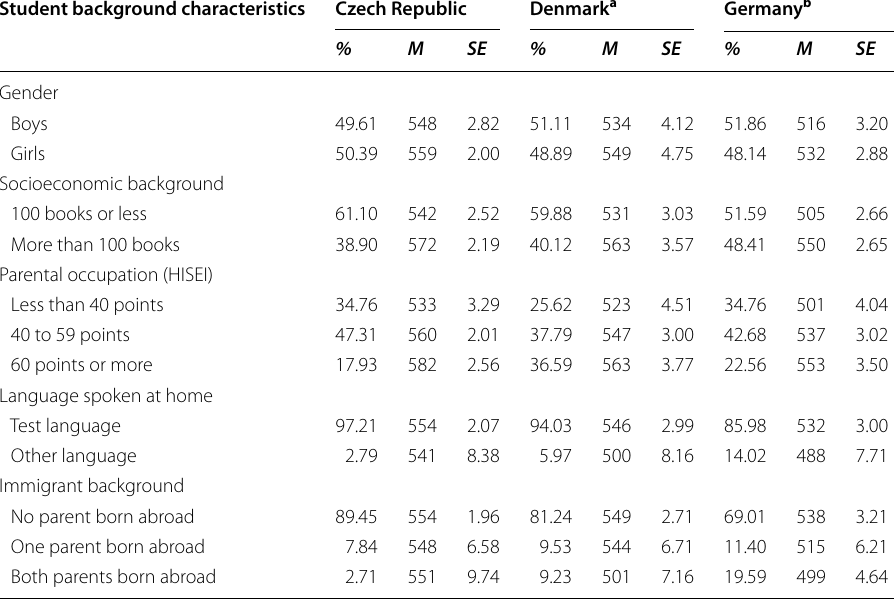
Table 1 Overview of descriptives of background characteristics related to computer and information literacy (CIL) of different groups of 8 th grade students in Czech Republic, Denmark and Germany (see also Fraillon et al.,